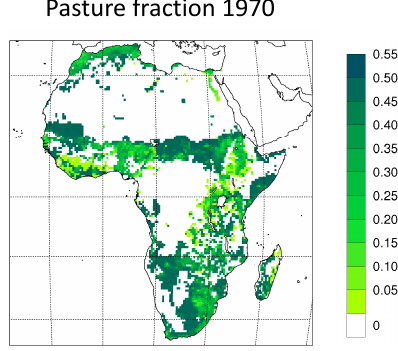
Fig. A4. Pasture fractions for 1970, derived from the HYDE database (Klein Goldewijk and Batjes, 1997).